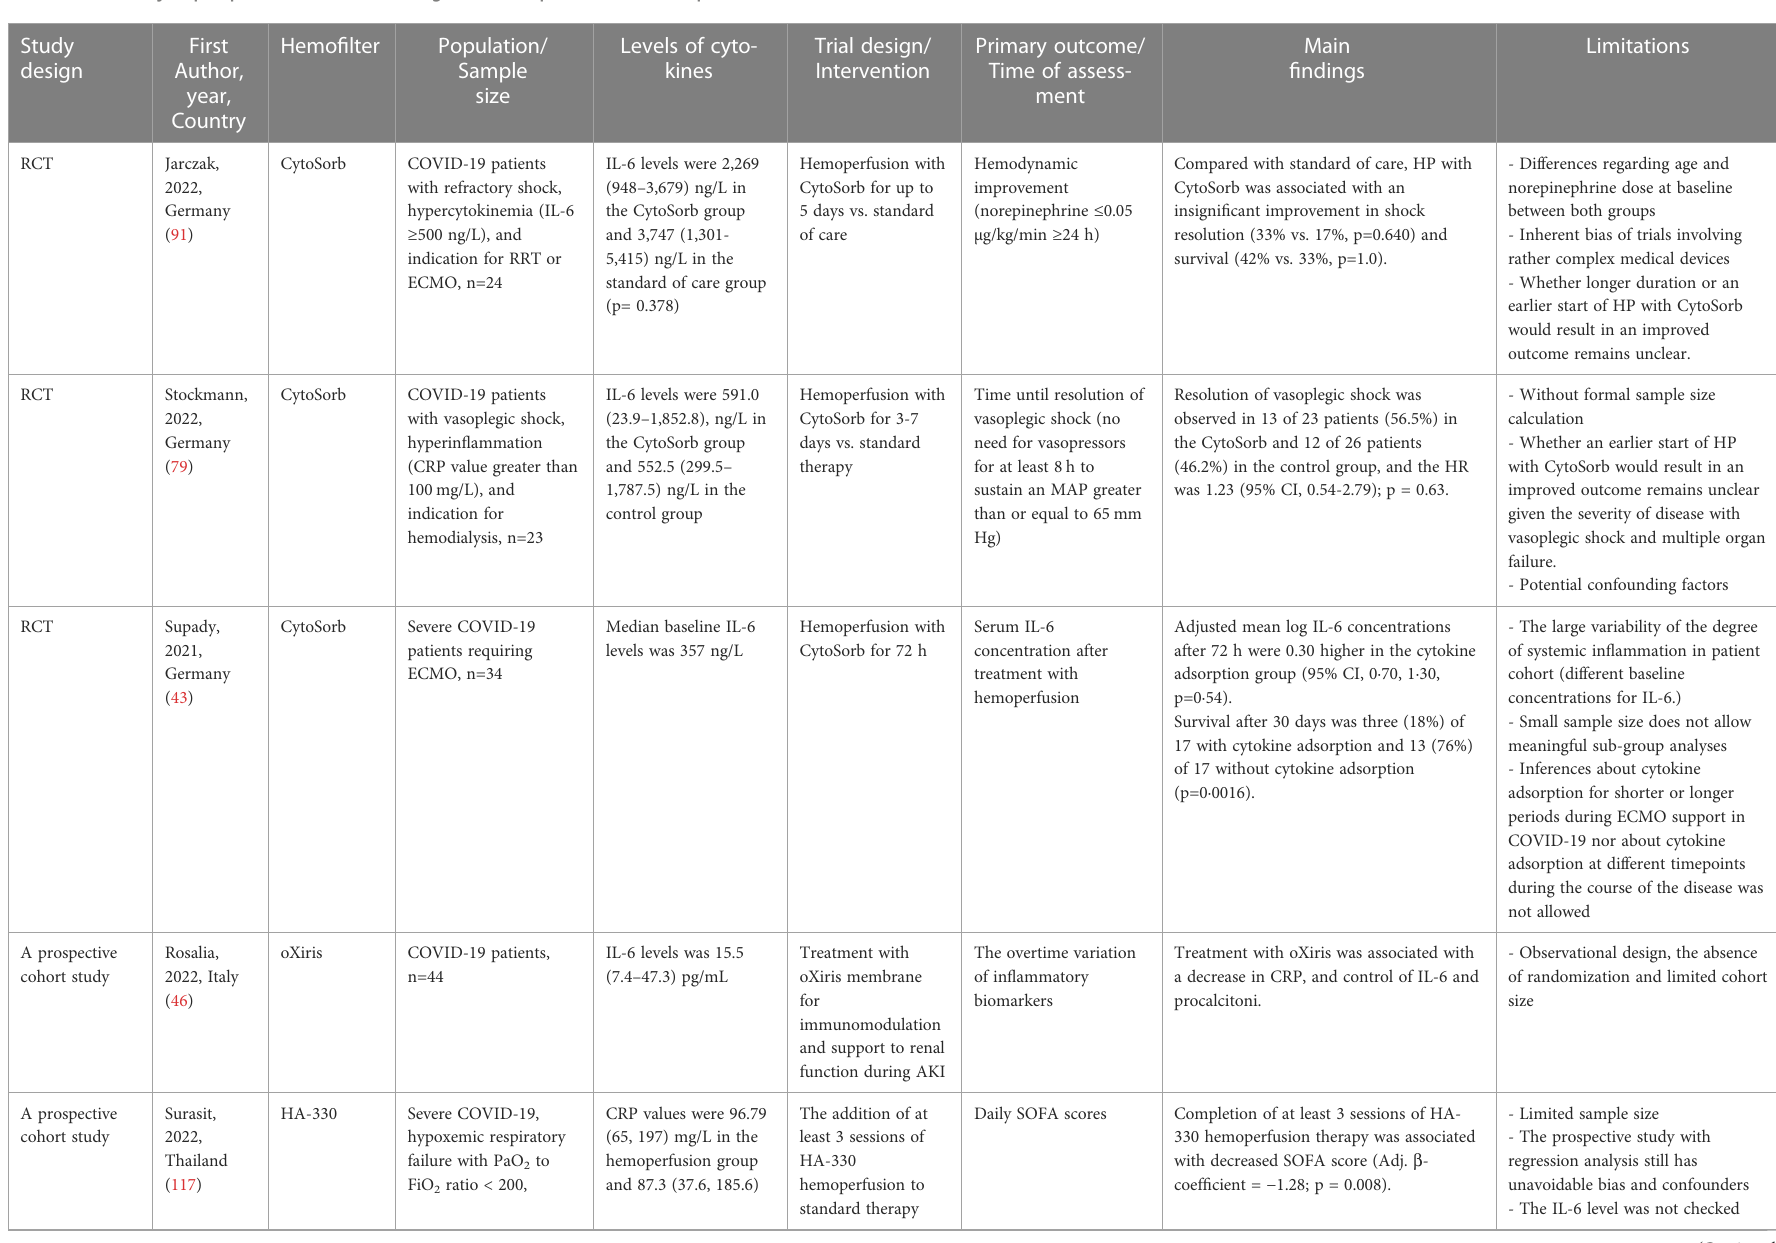
TABLE 2 Summary of prospective studies evaluating hemoadsorption in COVID-19